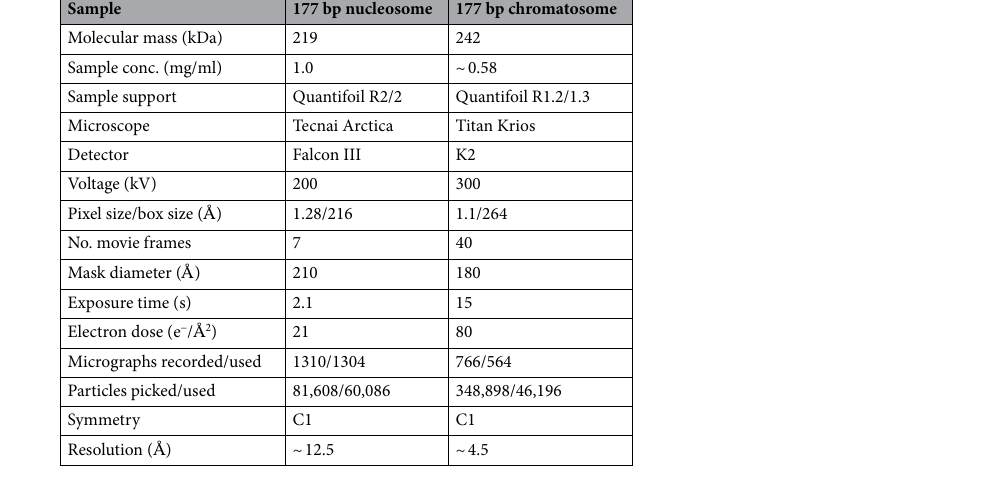
Table 1. Cryo-EM data collection and image